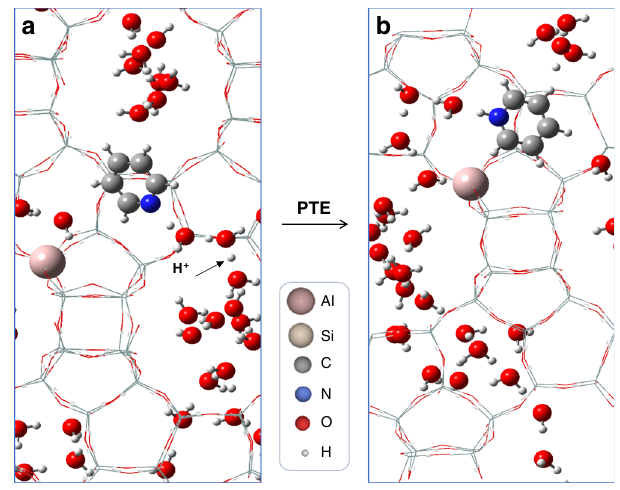
Fig. 6 DFT Optimized H/Beta structures with 28 water molecules per unit cell demonstrating the PTE. a The speci fi c acid (protonated water cluster) structure and neutral pyridine and b pore-phase pyridinium (PyrH + ) and neutral co-adsorbed water.